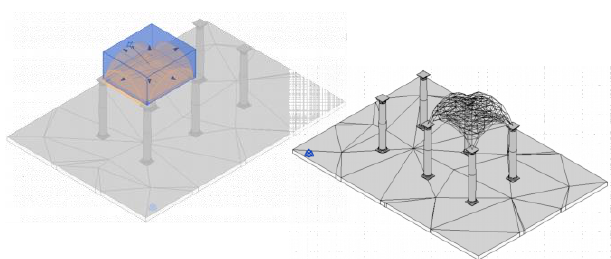
Figure 14. Ad-hoc modelling of the vaults